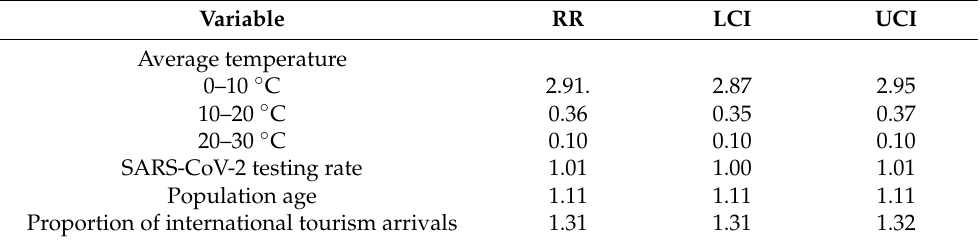
Table 3. The incidence rate ratio of SARS-CoV-2 according to temperature.